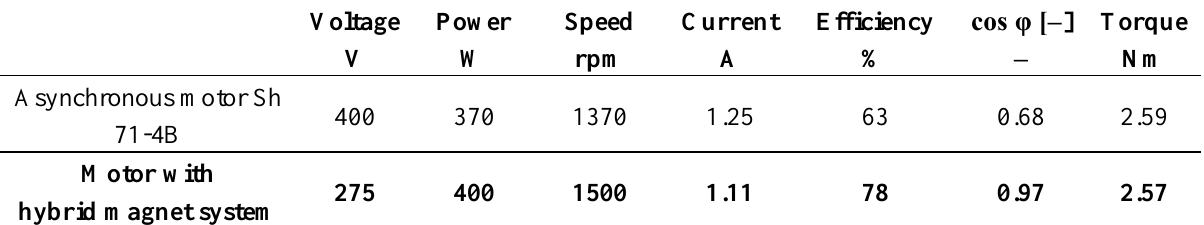
Table 1. Parameters of electric motor with hybrid magnet system and asynchronous